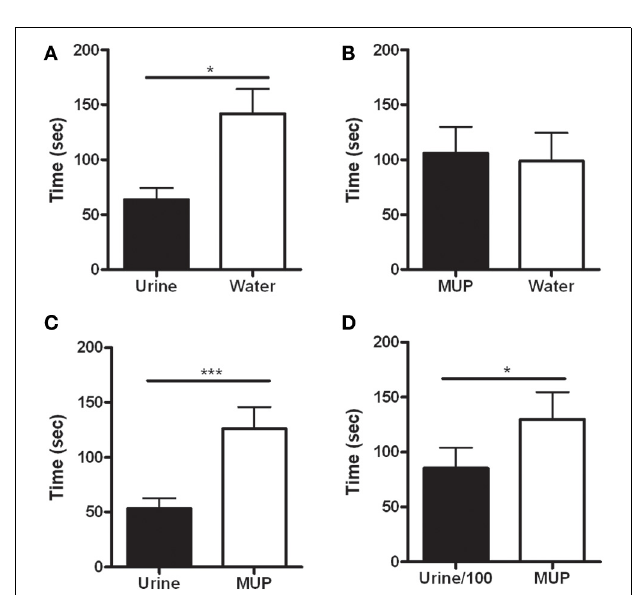
FIGURE 3 | Latency to the first rearing in the four experimental conditions. (A) Urine—Water; (B) sMUP—Water; (C) Urine—sMUP;